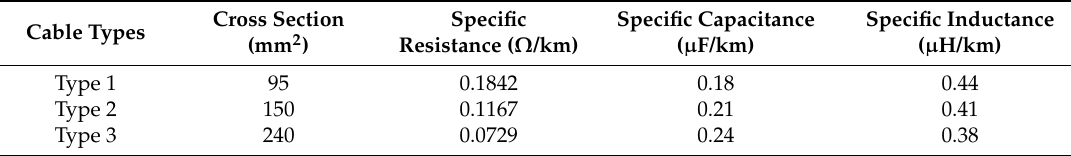
Table A2. Network